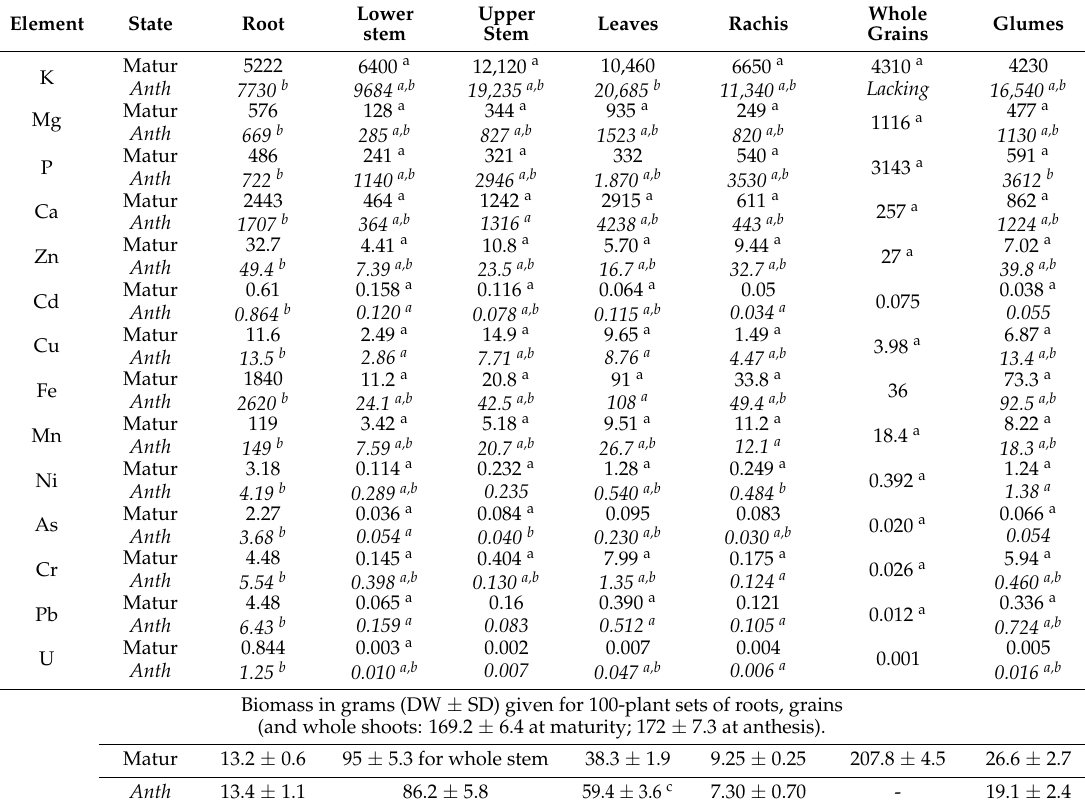
Figure 1. Variation in concentrations of minerals from the root (R; 100%) via the lower part (12 cm) of the mature wheat stem (LS) to upper stem (US), rachis (RA), and grain (G) in plants of cv. JB Asano grown on the metalliferous soil A ( a ) and the non-contaminated soil C ( b ). Values are arithmetic means for sets of minerals with similar modes of passage. Compare Tables 3 and 4 for significant differences within the flow of the individual elements. Table 4. The course of the mineral concentrations (mg · kg − 1 · DW) across the plant sections of wheat cv. JB Asano in the states of maturity (18 July) and anthesis (22 May). The plants were grown on the non-contaminated reference soil C (compare Table